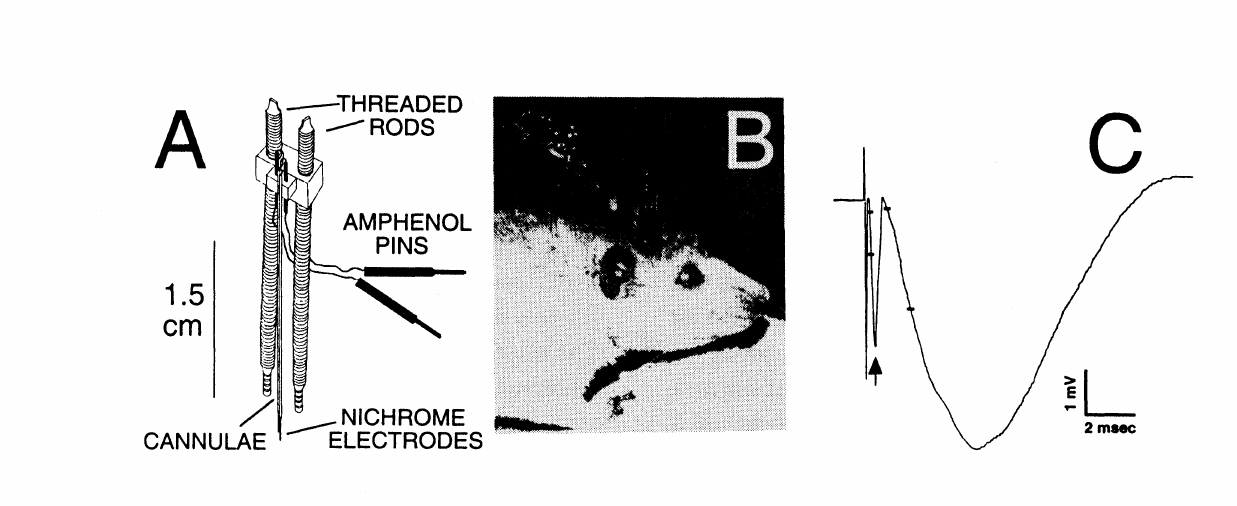
Fig. 1" A. Schematic of the implanted microdrive. A pair of 30 gauge cannulae, each containing a nichrome stimulating or recording electrode, is glued to an amphenol strip. The amphenol strip is loaded with two threaded stainless- steel support rods whose legs have been filed down to remove the threads. Grooves are then cut in the legs, allowing the influx of dental acrylic that prevents the legs from moving vertically after the drive is implanted. B. Photograph of a rat with the microdrive apparatus. The animal is shown connected to preamplifying headstage and recording and stimulating cable. C. Example of the Schaffer collateral evoked response, consisting of the presynaptic fiber potential (’1") and the extracellular field EPSP. The cursors indicate the positions at which the fiber potential and the EPSP amplitudes were